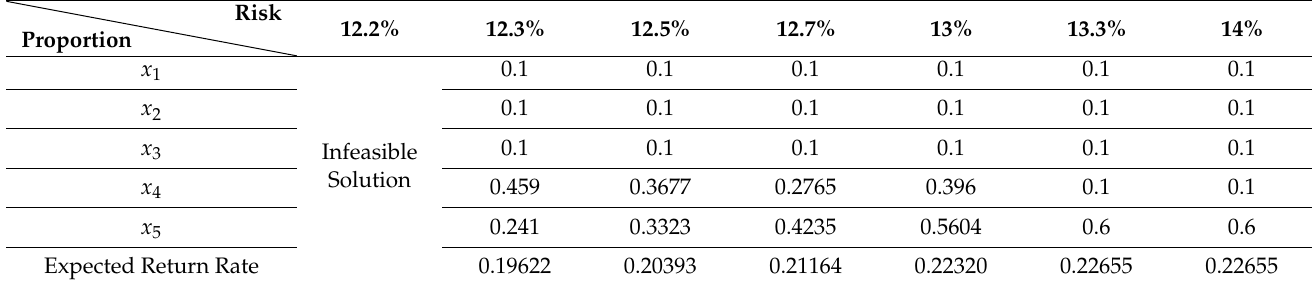
Table 5. The efficient portfolio with s = 1 in a guaranteed return rate (cid:101) p 2 .